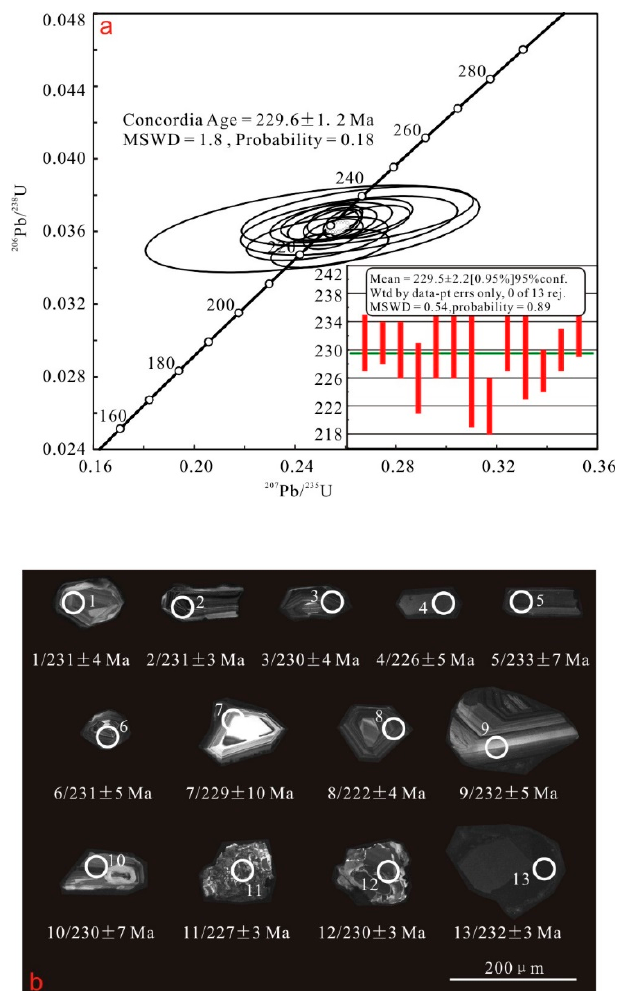
Figure 4. LA-ICP-MS zircon U-Pb concordia diagrams ( a ) and CL images ( b ) for the syenite in the Saima deposit.